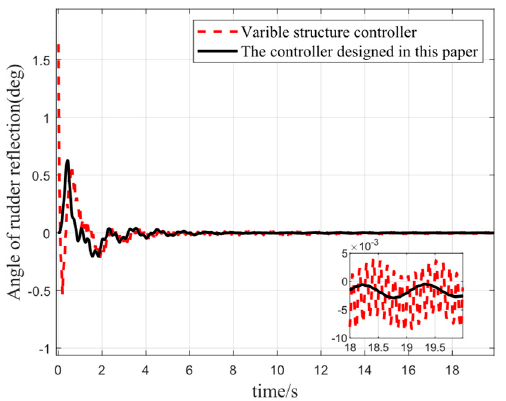
Figure 9. Fifth ‐ order elastic vibration mode without external interference.